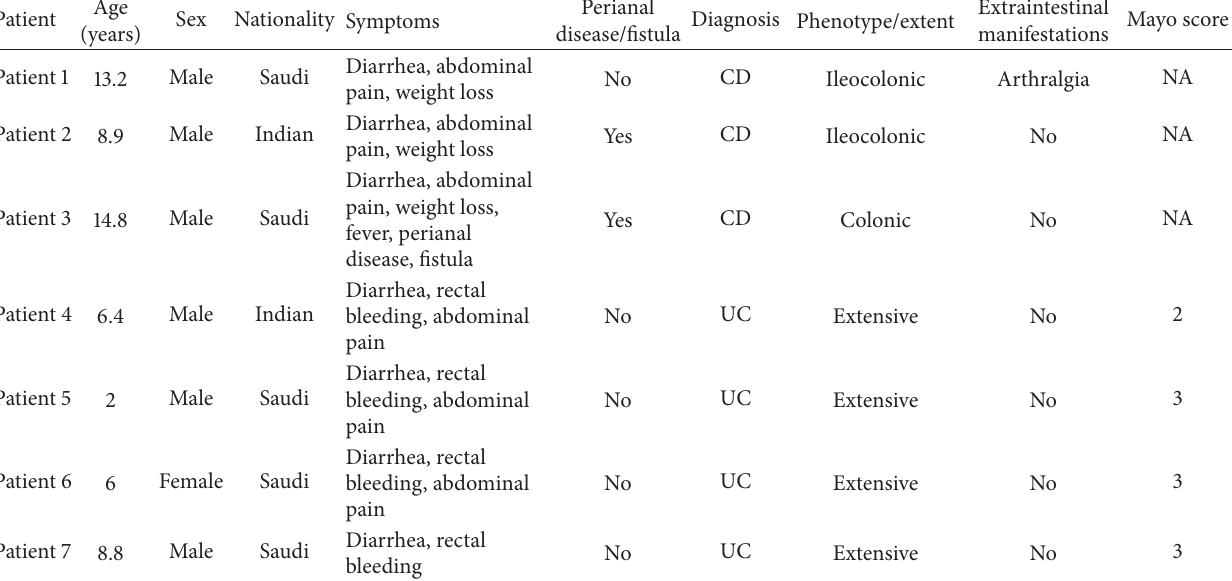
Table 1: Characteristics of IBD patients with positive